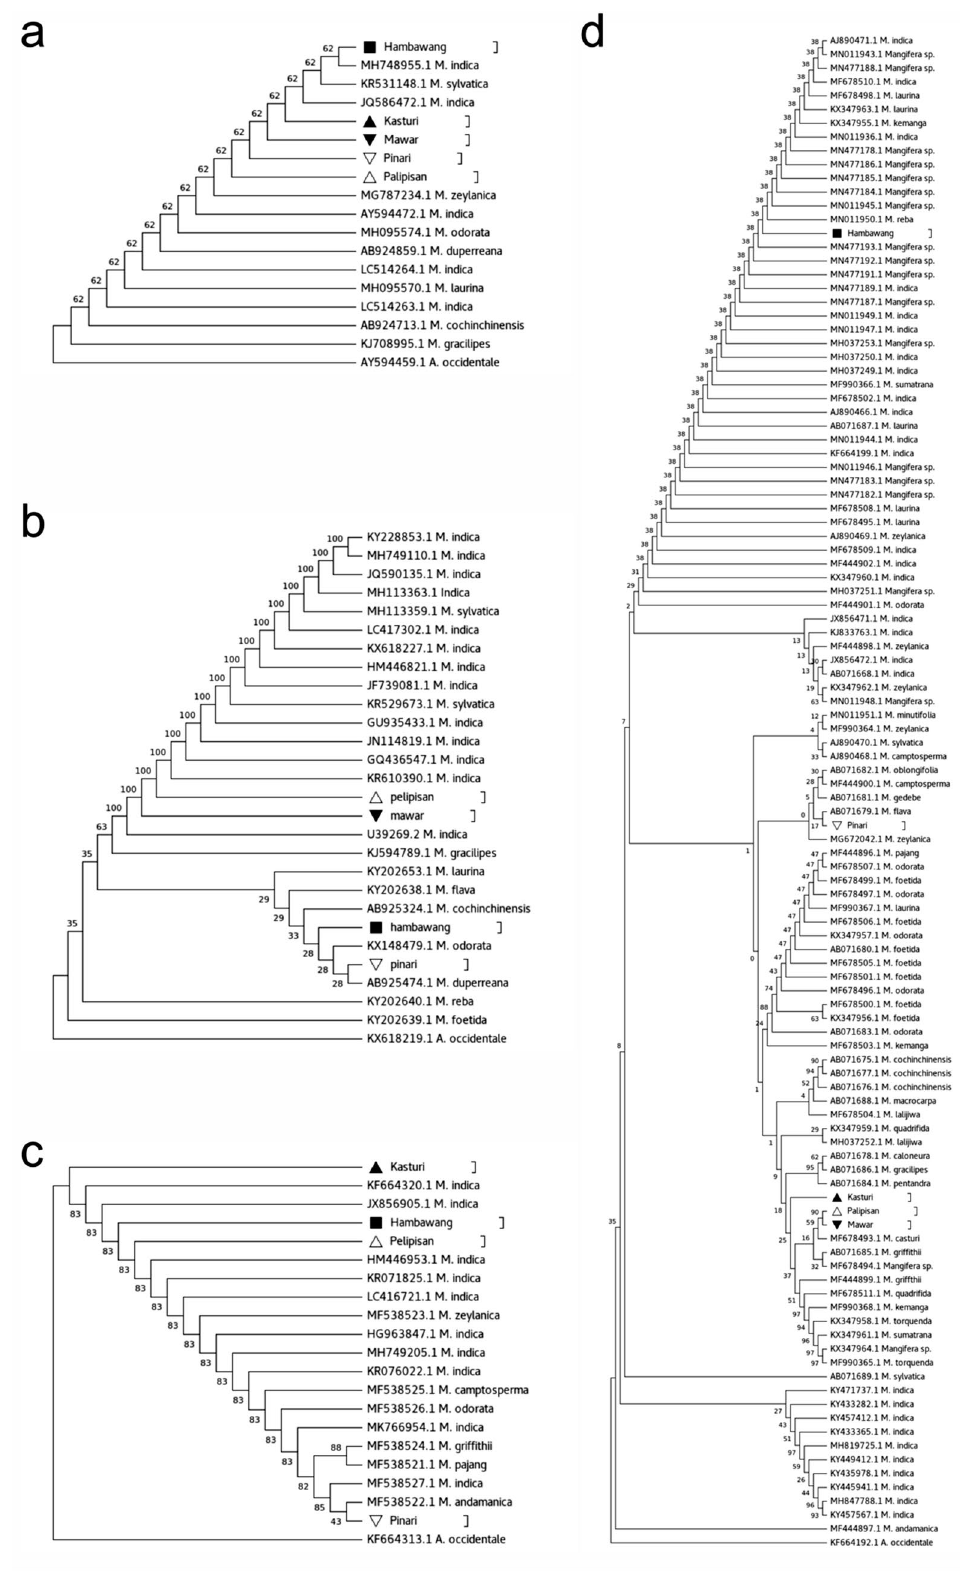
Figure 4. Phylogenetic analysis of M. casturi hybrids compared to the other Mangifera species (deposited in NCBI, Supplementary Table 2) using ( a) matK , ( b ) rbcL , ( c ) trnH-psbA , and ( d ) internal transcribed spacers (ITS) by Maximum Likelihood method. (The evolutionary history was inferred by using the Maximum Likelihood method and Tamura 3-parameter model for matK , trnH-psbA , ITS and Jukes-Cantor model for rbcL . The bootstrap consensus tree was inferred from 10 000 replicates. The tree is rooted with the outgroup, Anacardium occidentale.